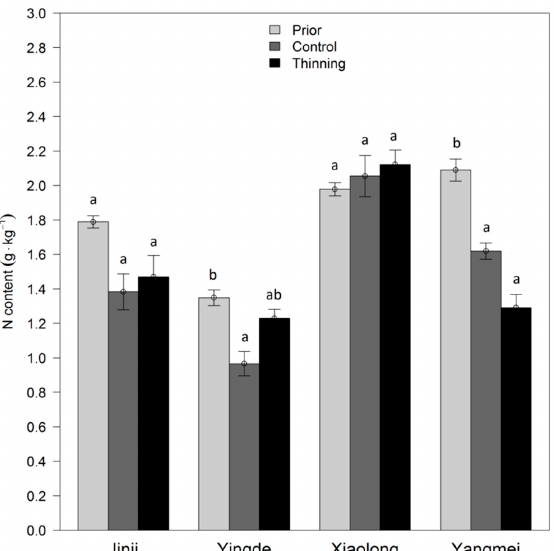
Figure 5. Nitrogen contents in the mineral soil (0–10 cm) in 2020 (Prior), and in the unmanaged plots (control), and thinning plots (thinning) in 2021. Error bars are standard errors of estimates. Significant differences between treatments in the same study site are indicated by different letters ( p < 0.05). The same letter in the same forest farm means no significant difference among prior, control and thinning. The different letters in the same forest farm mean significant differences among prior, control and thinning.